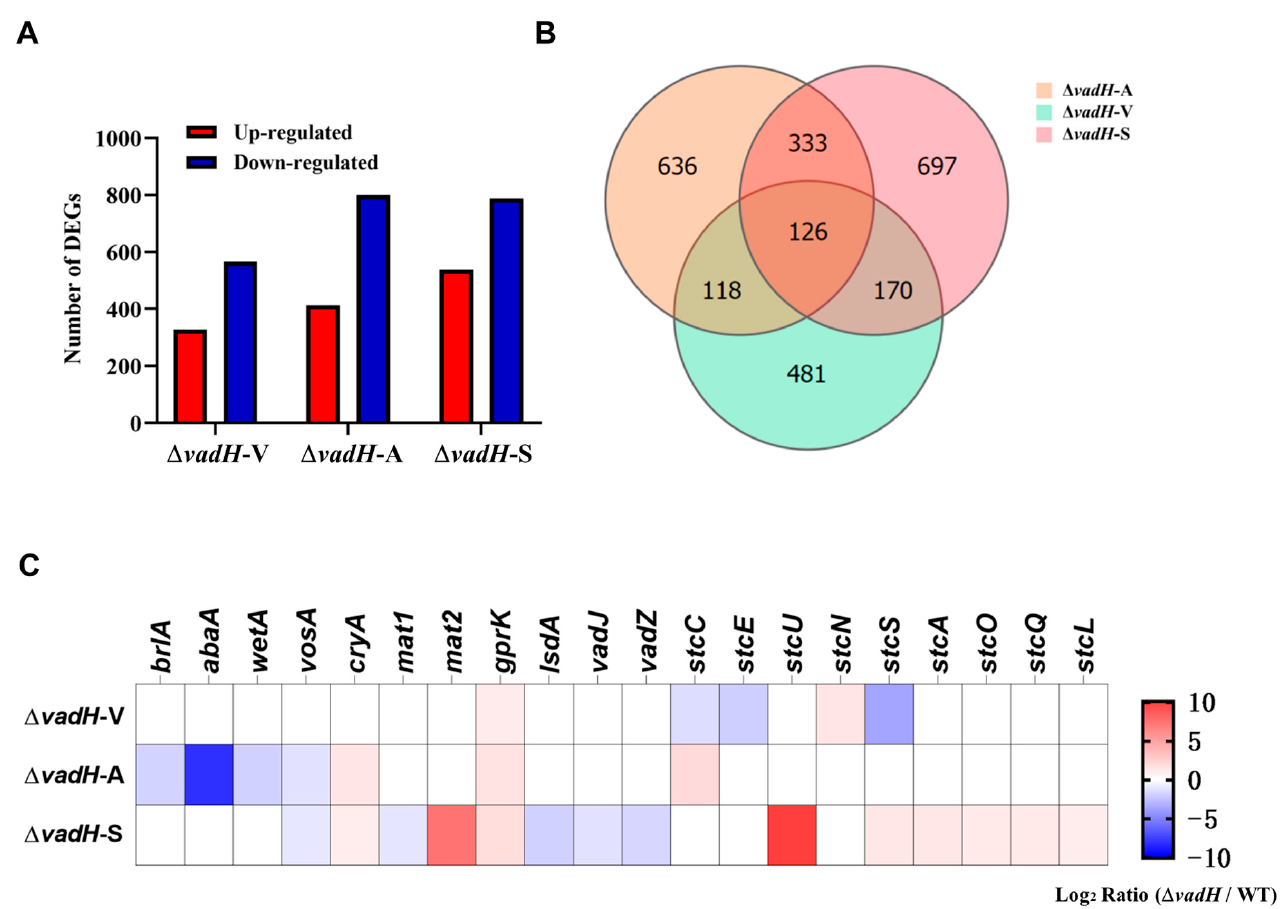
Figure 7. Results of RNA-Seq analyses. ( A ) DEGs statistics of Δ vadH at in three stages. Δ vadH -V: vegetative growth, Δ vadH -A: asexual development, Δ vadH -S: sexual development. ( B ) A Venn di- agram of DEGs in the three stages. ( C ) A heatmap of partial DEGs involved in asexual/sexual de- velopment and ST production.